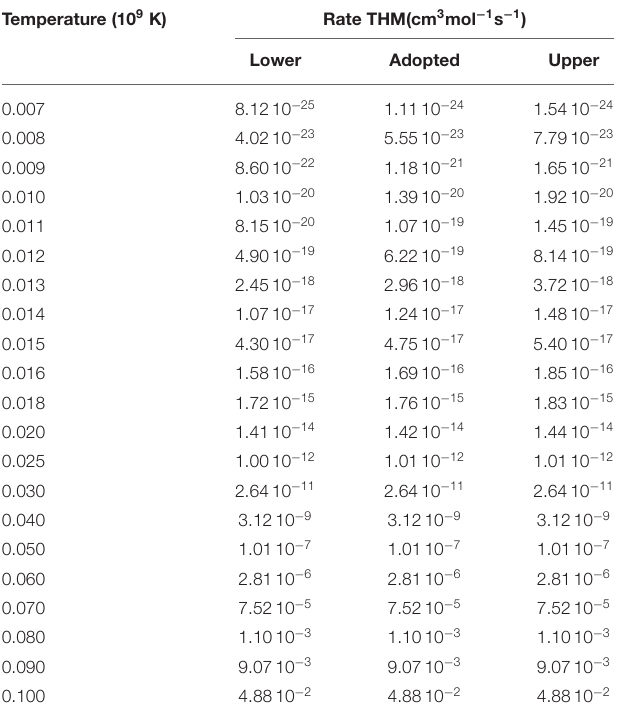
TABLE 5 | Rate of the 18 O( p , α ) 15 N